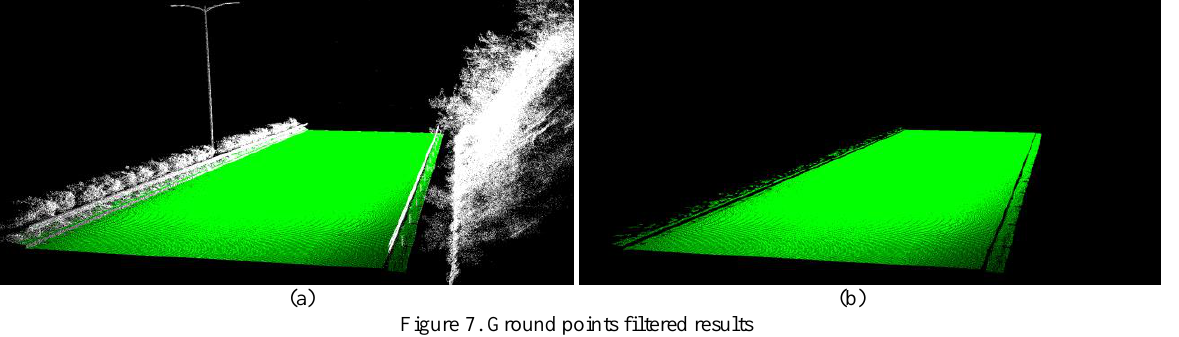
Figure 7. Ground points filtered results